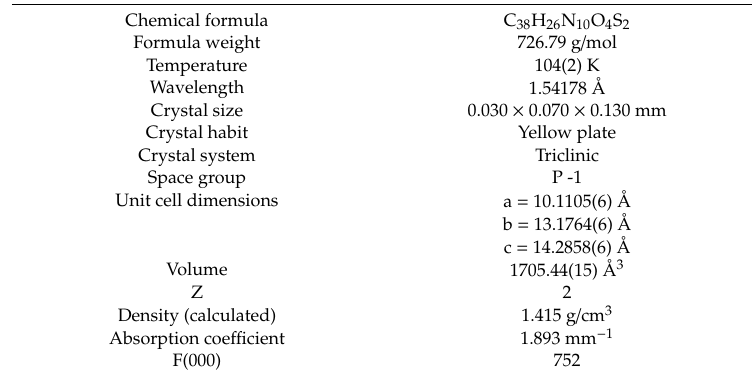
Table 1. Crystal data for 6 .